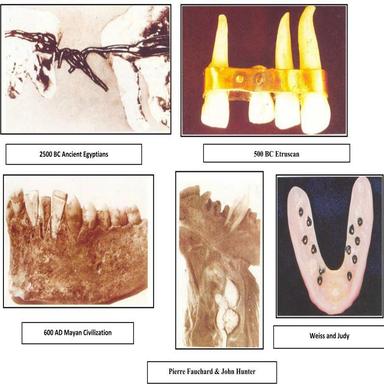
History of implants.